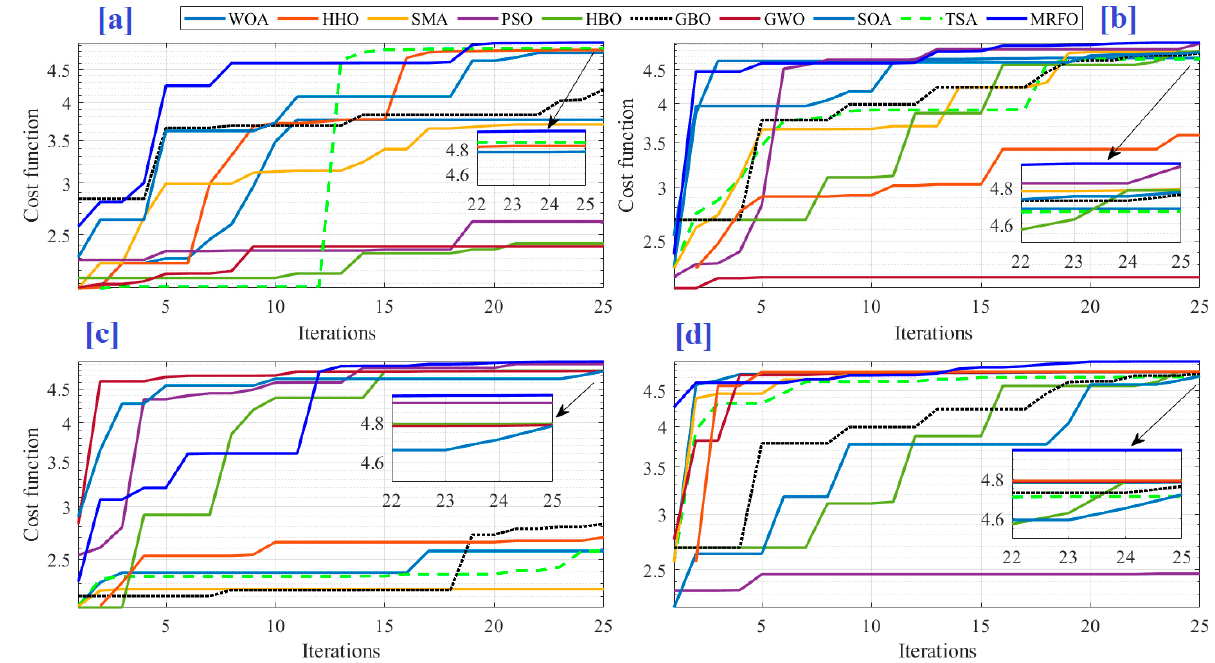
Figure 6. Cost function variation using different algorithms: ( a ) run no. 1; ( b ) run no. 9; ( c ) run no. 16; and ( d ) run no. 19.